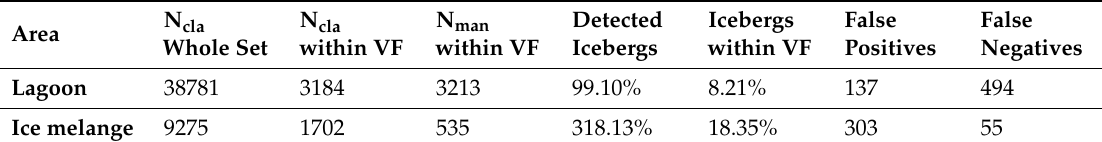
Table 5. Quantities of icebergs used in classification quality assessment. N cla stands for number of classified icebergs, N man – number of manually digitized icebergs and VF – Verification Fields.